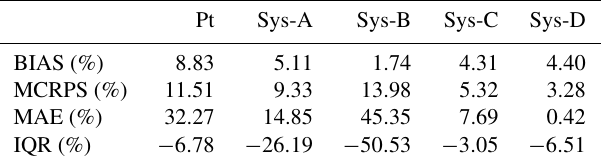
Table 4. Percentage of performance improvement (positive val- ues) or deterioration (negative values) brought by the precipita- tion post-processor according to each criterion of forecast quality (BIAS, MCRPS, MAE rd , IQR) when evaluating precipitation (Pt) and streamflow (Sys-A to Sys-D) forecasts. Pt Sys-A Sys-B Sys-C Sys-D BIAS (%) 8.83 5.11 1.74 4.31 4.40 MCRPS (%) 11.51 9.33 13.98 5.32 3.28 MAE (%) 32.27 14.85 45.35 7.69 0.42 IQR (%) − 6 . 78 − 26 . 19 − 50 . 53 − 3 . 05 − 6 .